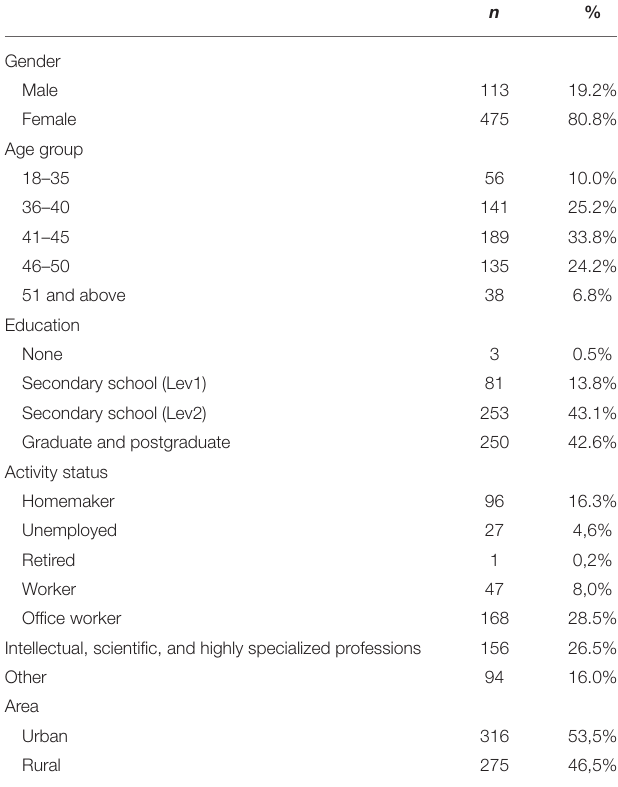
TABLE 1 | Sample characteristics ( n =